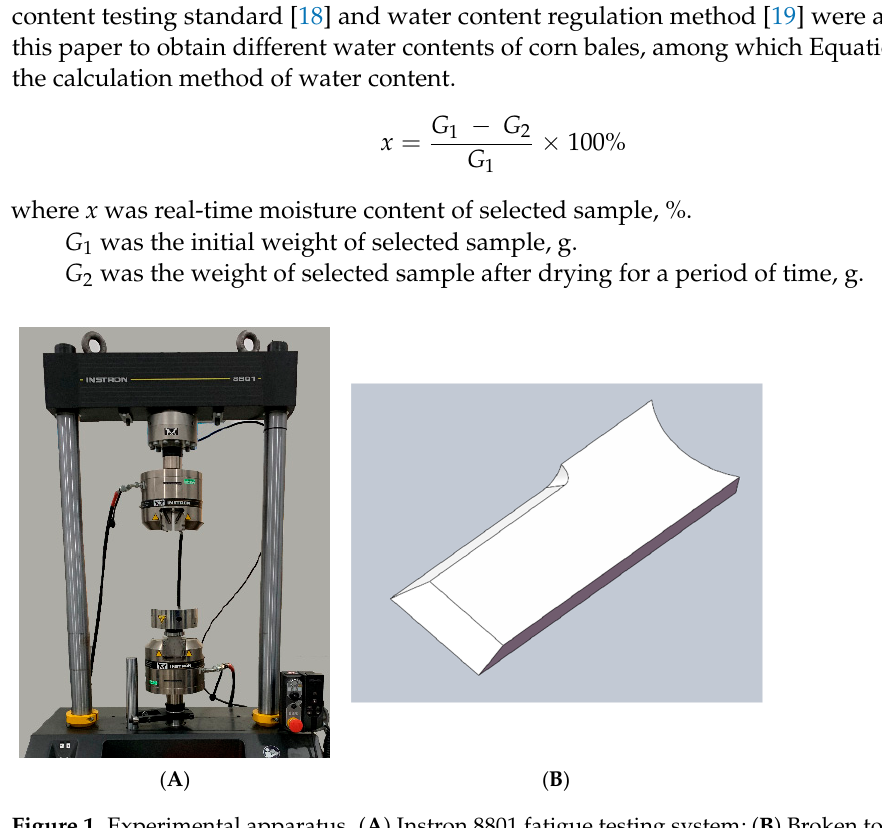
Figure 1. Experimental apparatus. ( A ) Instron 8801 fatigue testing system; ( B ) Broken tool.